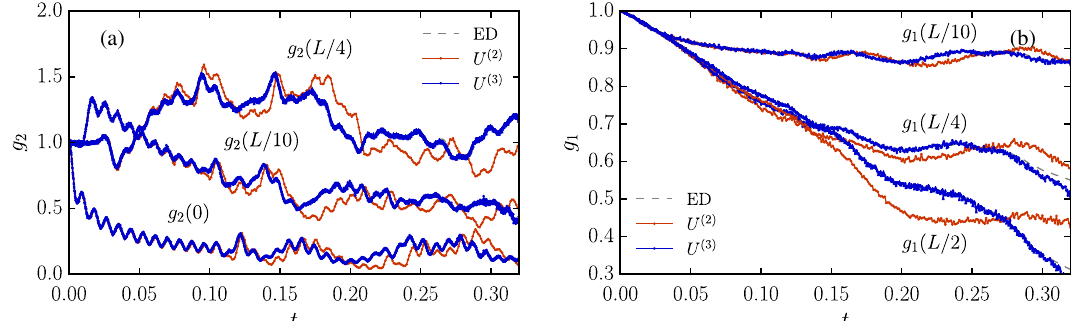
FIG. 5. (a) Time-dependent expectation value of the two-body correlations g 2 ð r; t Þ after a quantum quench from a noninteracting state, γ 0 , to γ 8 at three different distances, j x − x 0 , L= 10 , L= 4 . Here, the system is on a lattice with L=a ¼ 40 lattice sites. The 1 2 j ¼ i ¼ f ¼ full line is obtained by exact diagonalization of the Hamiltonian; the other curves are from tVMC results truncated at the level of U ð 2 Þ or 4 shown in Fig. 4, systematic differences of U ð 2 Þ compared to the exact results are more visible here; the exact U ð 3 Þ . In contrast to γ f ¼ dynamics is recovered by inclusion of three-body terms U ð 3 Þ into the tVMC wave function. (b) Off-diagonal single-particle density matrix g 1 ð r; t Þ at three different distances, r ¼ L= 10 , L= 4 , and L= 2 . The exact results (ED – black dashed line) are for all purposes indistinguishable from the U ð 3 Þ